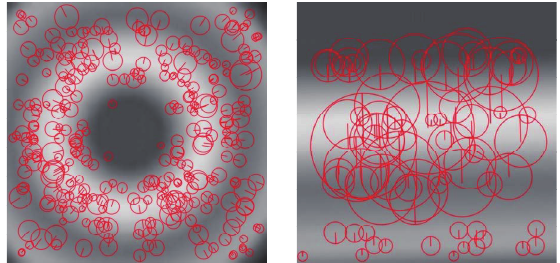
Figure 1. Gradient of AP signal and magnetic field in ideal